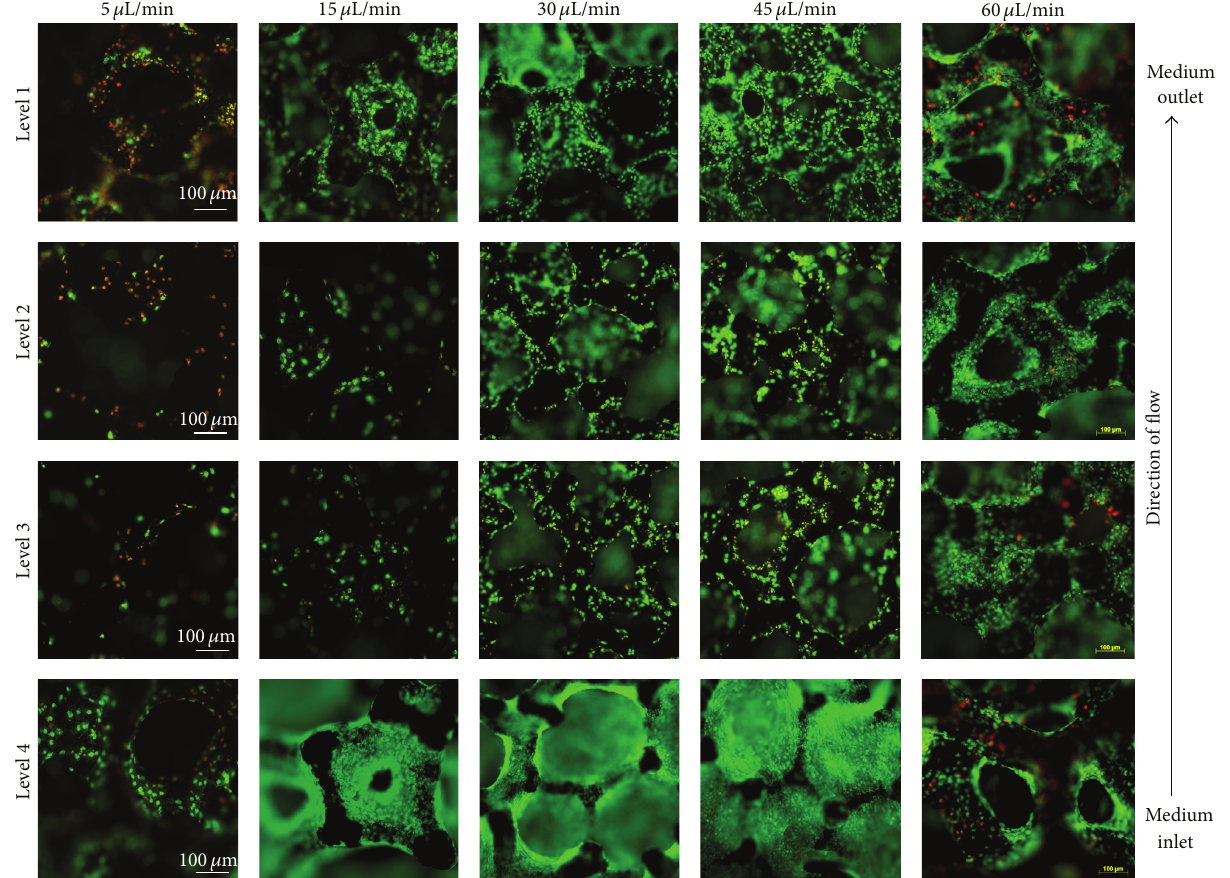
Figure 5: Dynamic cell culture with different medium flow rates for 7 days. Fluorescence images of MG-63 cell nuclei from the 4 different levels of the in vitro 3D module. Note that the best results for cell survival in the core region (levels 2 and 3) can be observed at perfusion flow rates of 30–45 𝜇 L/min. Interestingly, cell death could be detected at a higher flow rate of 60 𝜇 L/min, especially on level 4. Fluorescence images: nuclei of vital cells = green, nuclei of dead cells = red (Axio Scope.A1, magnification 10x, bar 100 𝜇